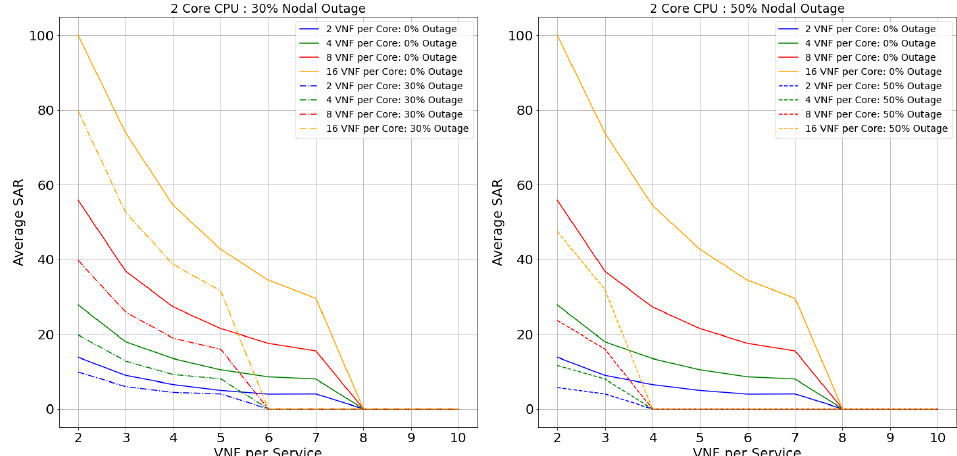
Figure 13. SAR: Netrail Topology with Nodal Outage—2 Core CPU.